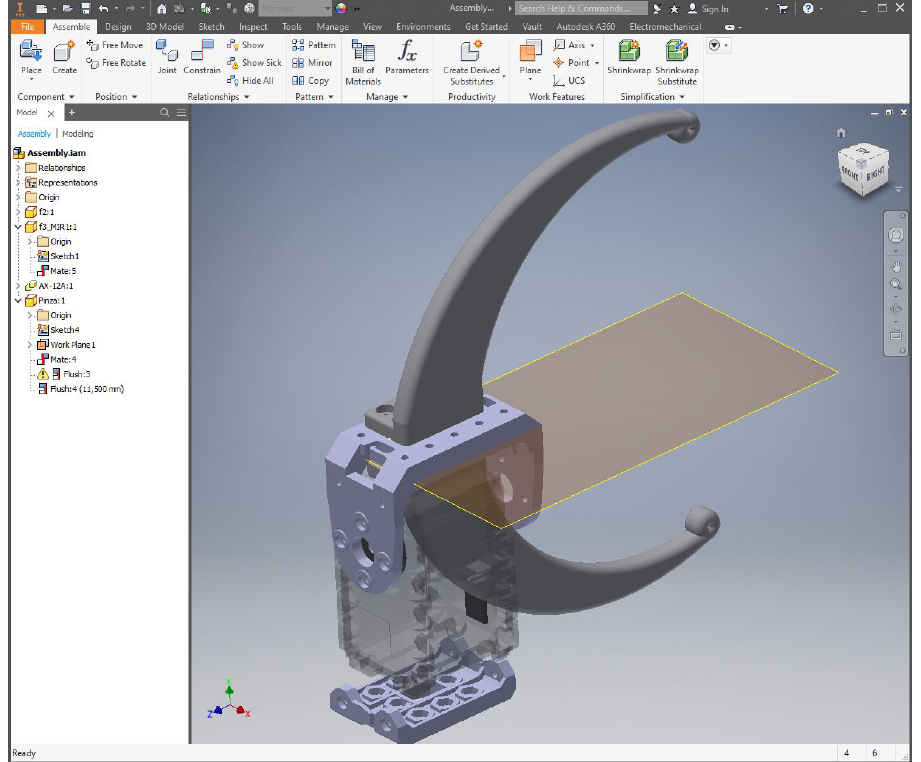
Figure 11. Example of orientations given to Bachelor’s and Master’s students to design a